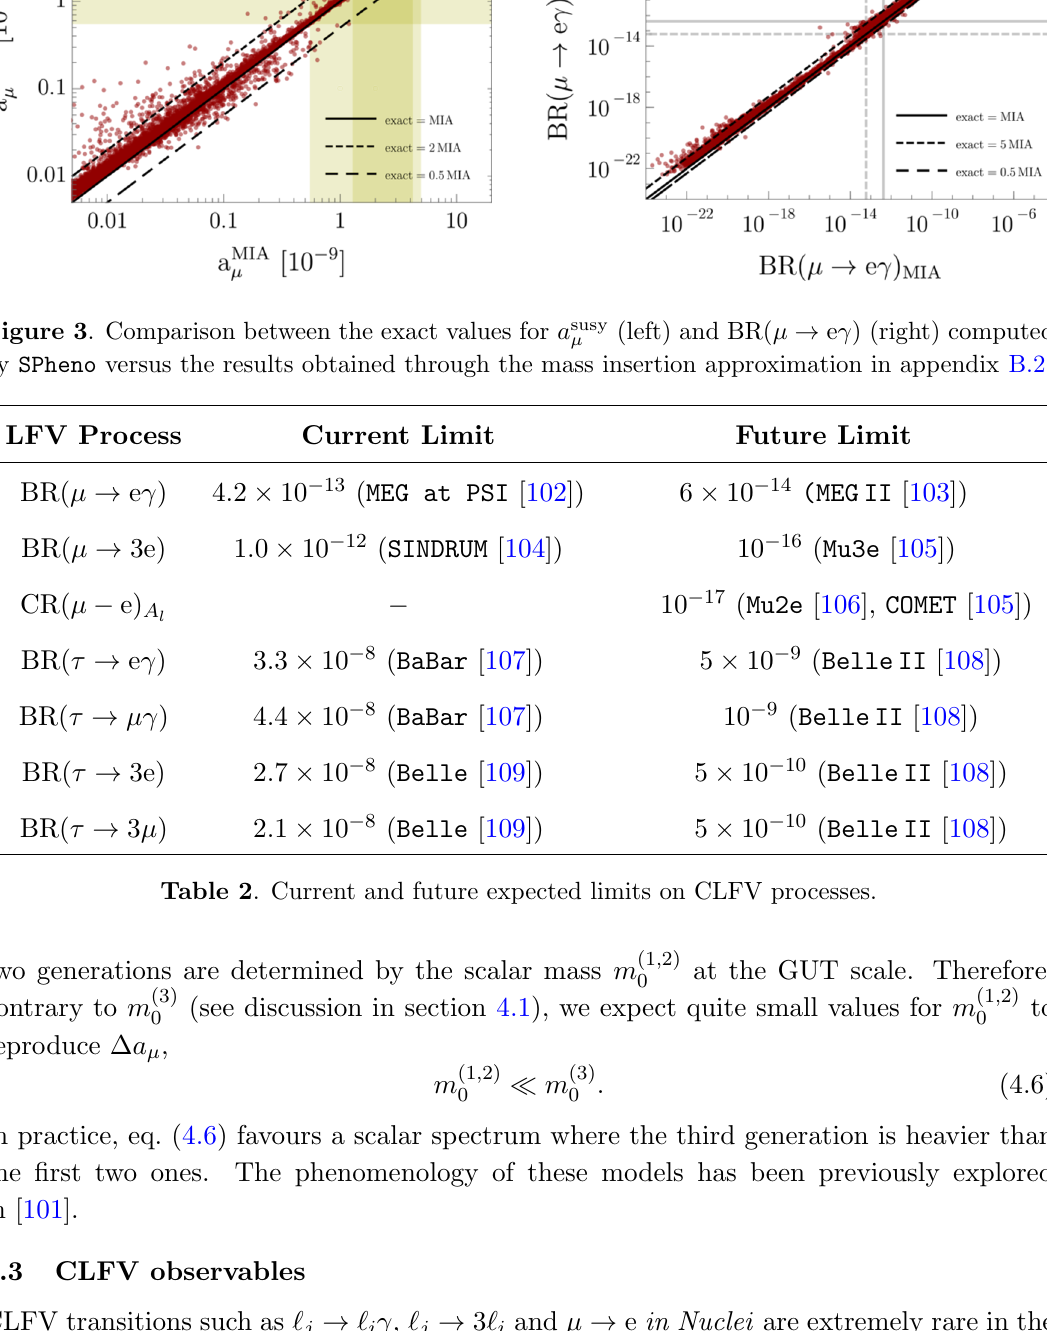
(left) and BR( (cid:22) ! e (cid:13) ) (right) computed (cid:22)